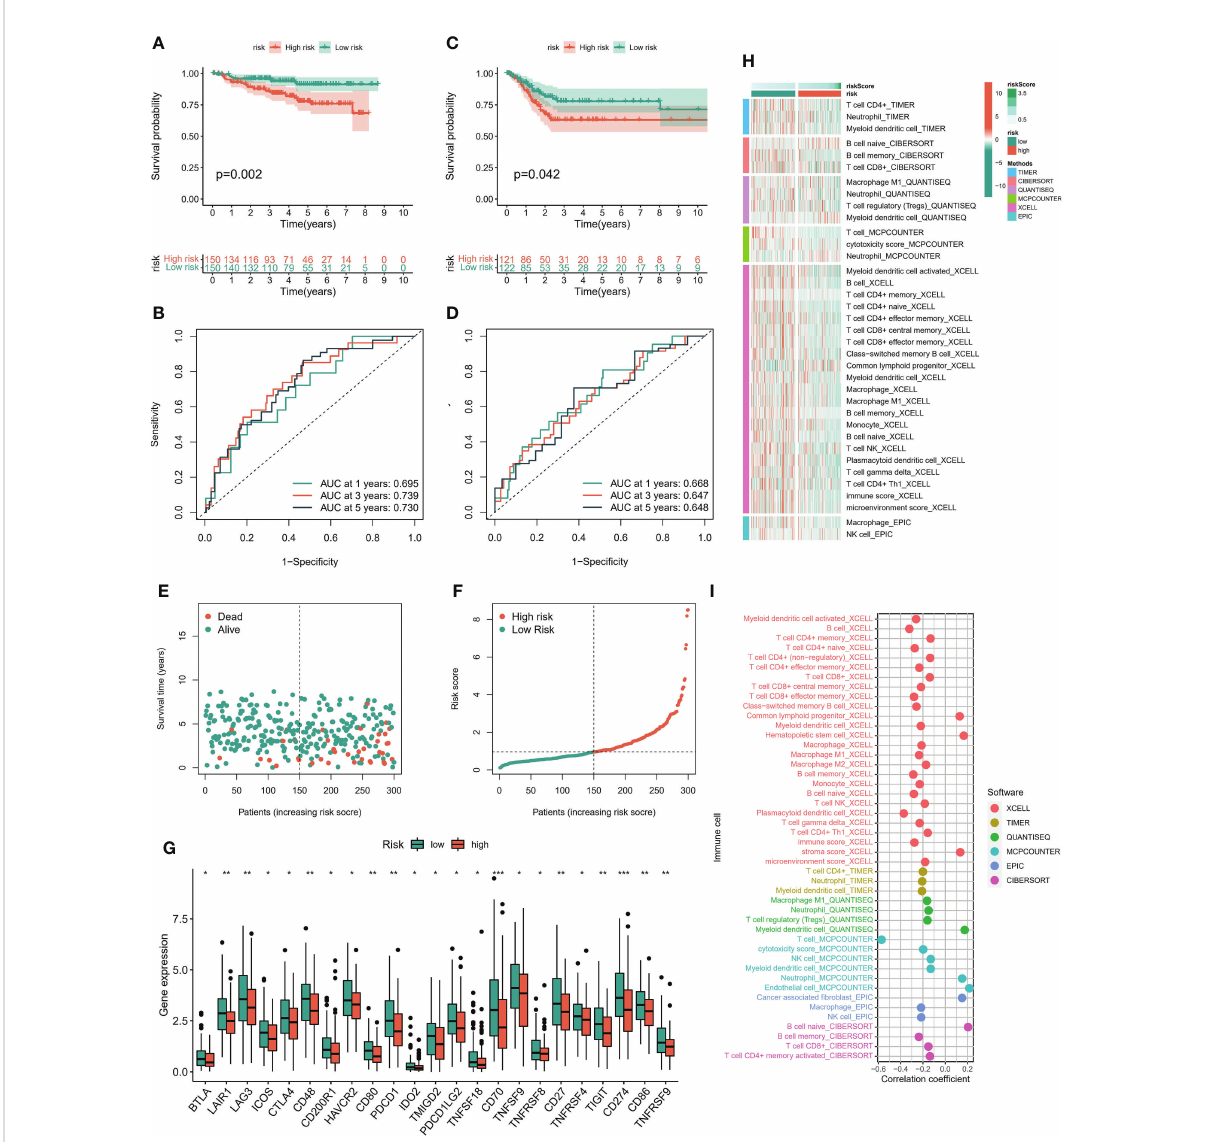
FIGURE 5 Immune cell in fi ltration landscape. (A) The K-M survival model was constructed to explore the predictive performance in TCGA cohort. (B) The ROC curve was conducted to verify the predictive performance of predictive model in TCGA cohort. (C) The K-M survival model was constructed to explore the predictive performance in GEO cohort. (D) The ROC curve was conducted to verify the predictive performance of predictive model in GEO cohort. (E, F) Distribution of risk score and survival status of patients with cervical cancer. (G) Expression of immunomodulators between high and low risk groups. (H) Heatmaps constructed by six immune in fi ltration analysis algorithms were employed to assess the level of cell in fi ltration among each subpopulation. (I) Correlation between immune cell in fi ltration level and riskscore. *P < 0.05, **P < 0.01, ***P <